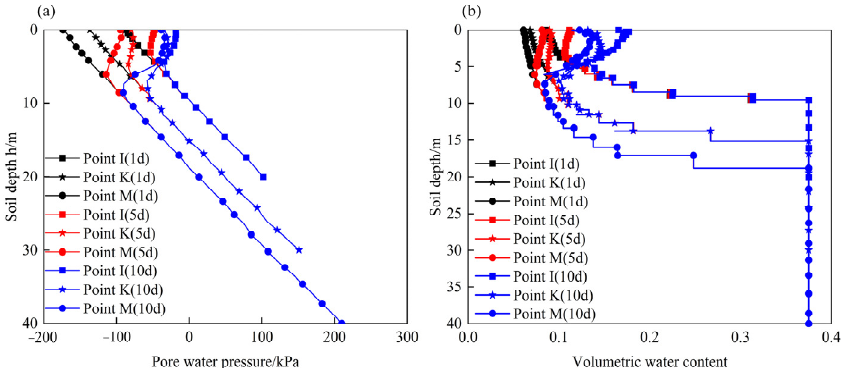
Figure 11. Distribution curves of pore water pressure and volumetric water content with the depth of the slope without protection after rainfall: ( a ) pore water pressure; ( b ) volumetric water content.